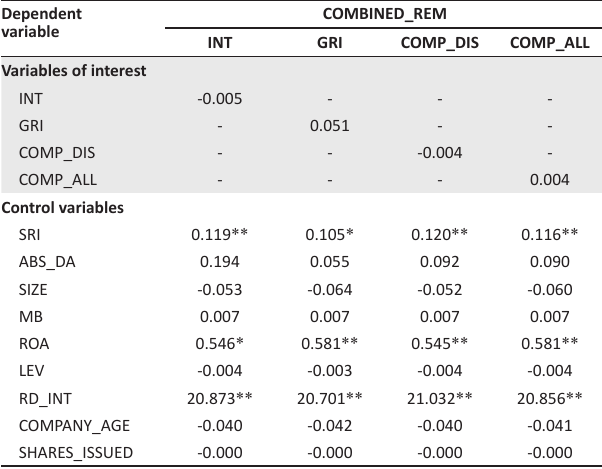
TABLE 7: Real earnings management on corporate social responsibility